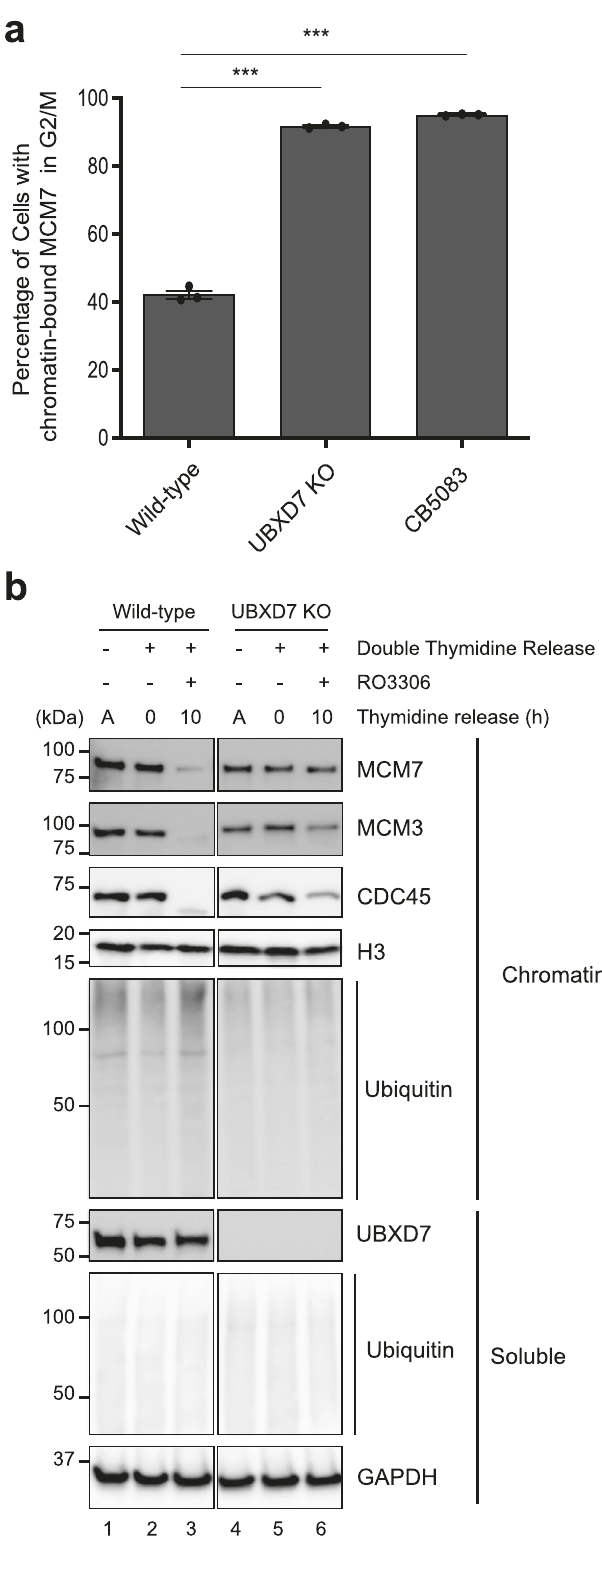
Fig. 5 | hUBXD7 is required for CMG unloading in mammalian cells. a Quanti fi cation of MCM7 levels on chromatin in the G2/M phase of cell cycle in wild-type HFT cellsin the presence or absence of the p97 inhibitor CB-5083 and in hUBXD7 KO cells. Bars represent mean, and error bars represent SD from three independent repeats. Asterisks indicate statistical signi fi cance compared with the control,asdeterminedbyonewayANOVAandTukeytestformultiplecomparisons (*** P <0.0001).SeealsoSupplementaryFig.7. b Wild-typeorhUBXD7KOHFTcells were allowed to grow asynchronously or they were synchronized with double thymidine and then optionally releasedinto RO3306for 10h, asindicated.Soluble andchromatinboundproteinswereblottedfortheindicatedproteins.Theimages are all part of the same Western blot, which was cropped to remove irrelevant information between lanes 3 – 4. A, asynchronous. Source data are provided as a Source Data fi